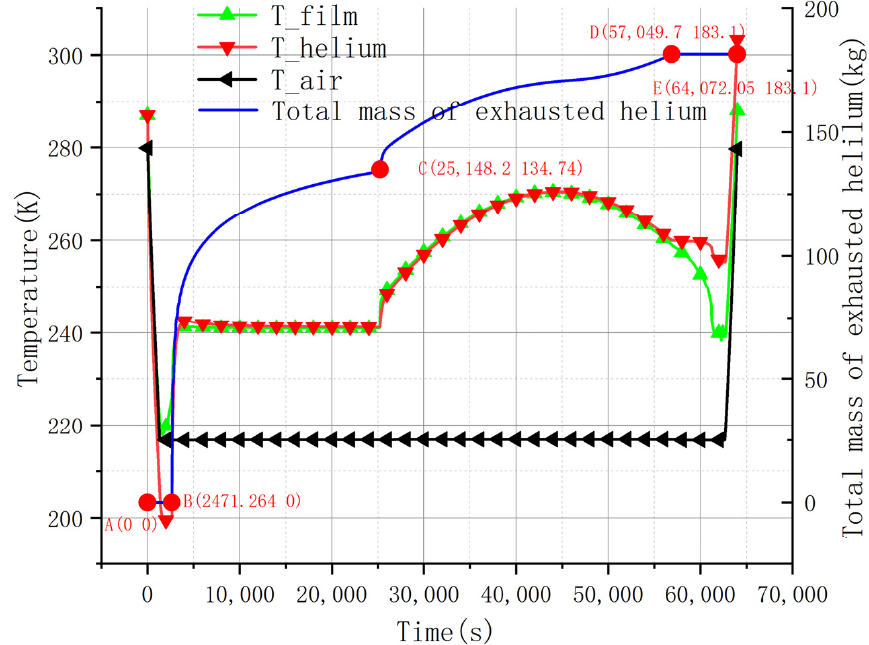
Figure 8. Temperature change of the film, helium, and air vs. time, and the change of the total mass of exhausted helium vs. time.